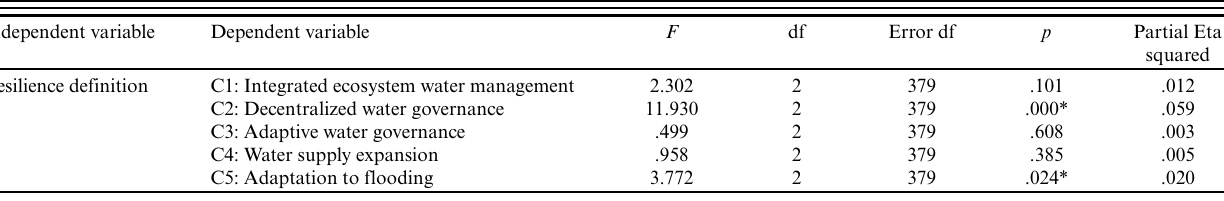
Table 2 . Follow-up univariate one-way ANOVA results. The relationship between the PCA components and the three resilience definitions was tested. The overall MANOVA test results show that the difference between groups was significant ( F (10, 750) = 3.857, p < .0005; Wilks” Λ = .905; partial η 2 = .049.) The sample size was